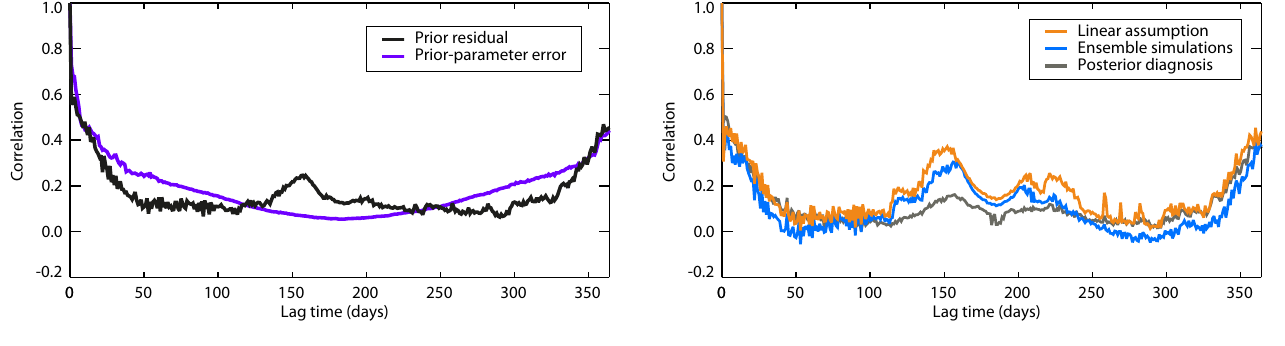
Fig. 2. All-site median of the autocorrelation of the observation er- ror (i.e., model error + measurement error) R , estimated at each site with three methods: prior diagnostics with the linear assumption prior (orange, ˆ R from Eq. 1), prior diagnostics with ensemble sim- prior ulations (blue, ˆ R from Eq. 1), and posterior diagnostics (grey, ˆ R post from Eq.